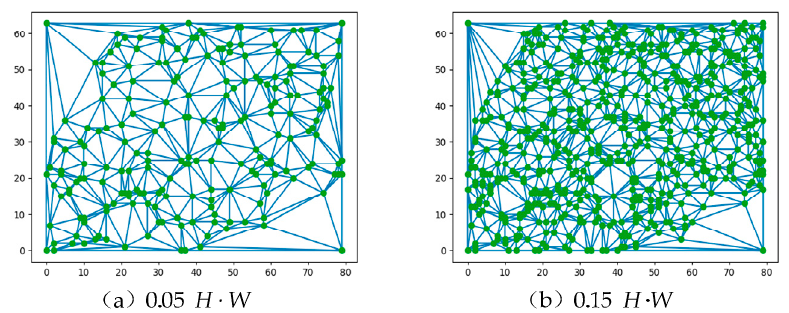
Figure 4. Triangular region constructed by sparse points: ( a ) visualization of a sparse triangular area constructed from 0.05𝐻 ∙ 𝑊 sparse points; ( b ) visualization of a dense triangular area constructed from 0.15𝐻 ∙ 𝑊 sparse points.